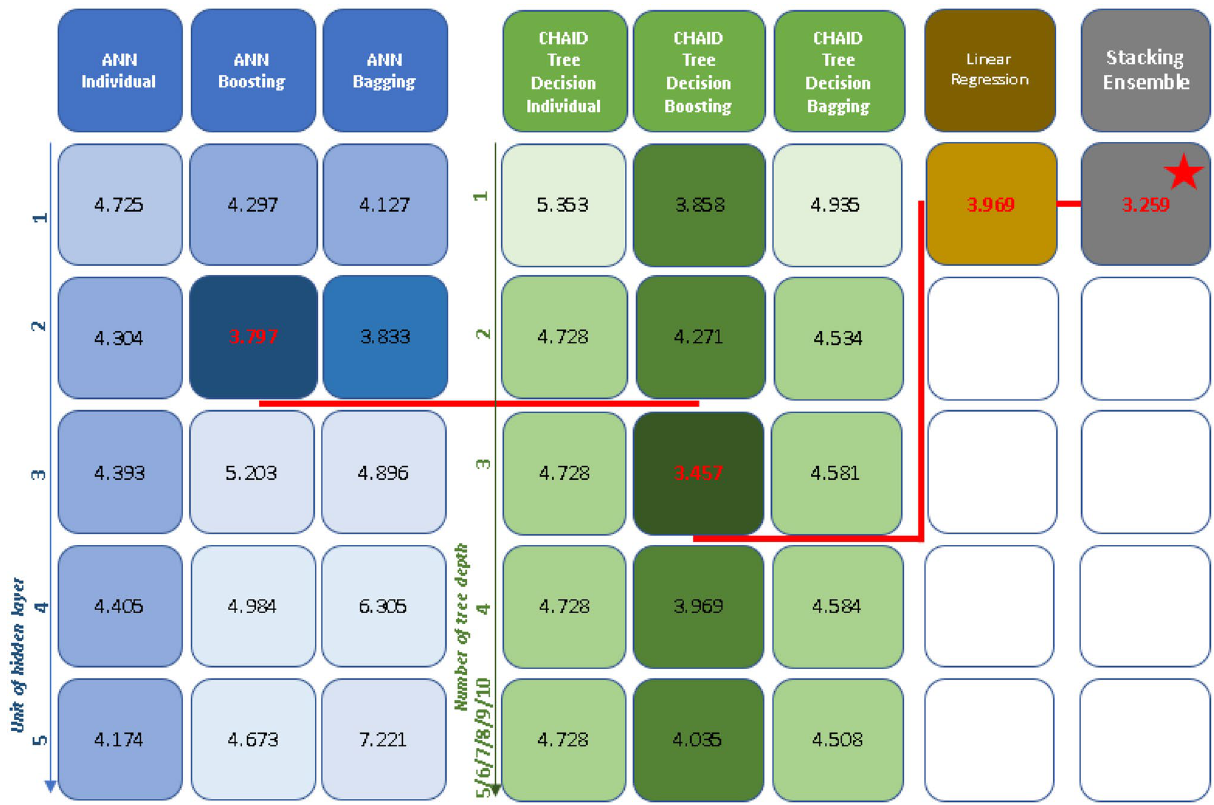
Figure 15. Mean absolute error performance matrices for prediction carbon steel corrosion in soil.